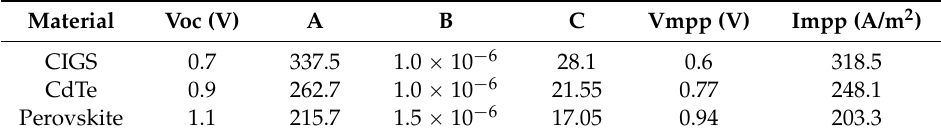
Table 1. Constants used for the IV curves on which the modeling was